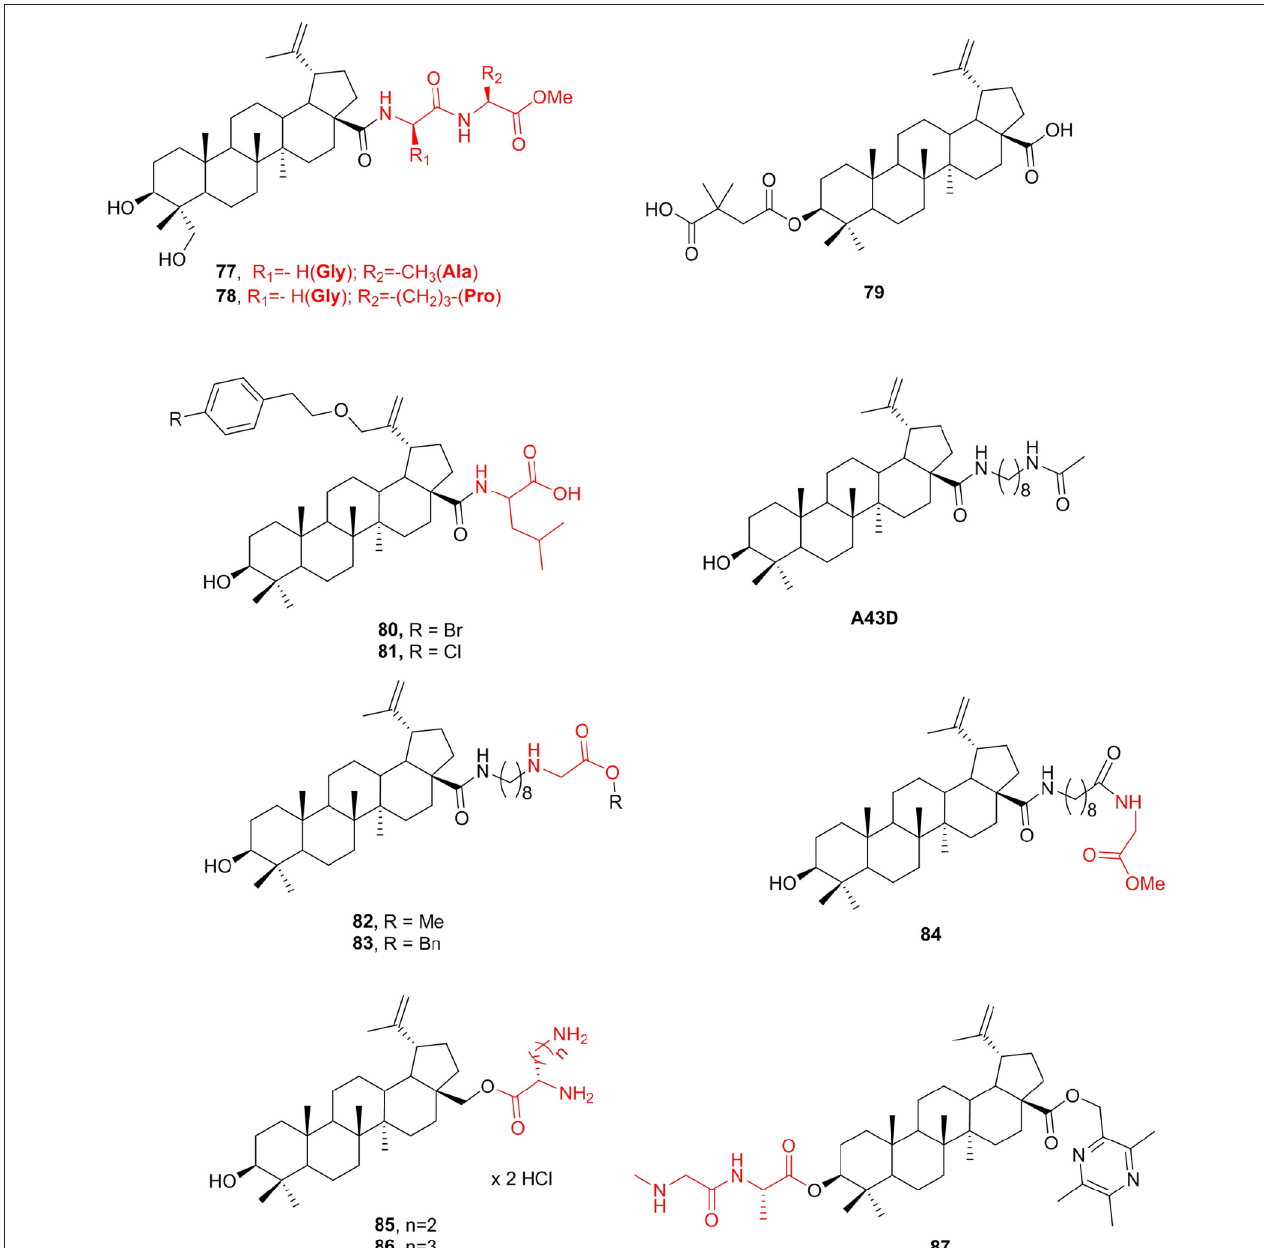
FIGURE 10 | Betulinic acid